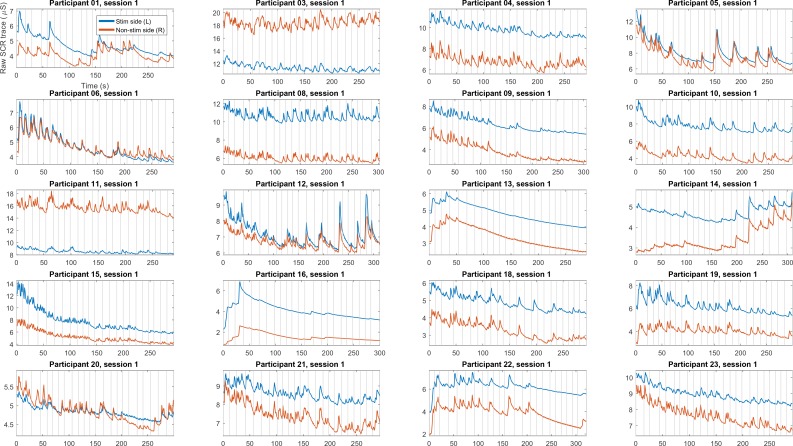
Experiment 2: raw skin conductance traces, where vertical lines are beginning of each trial when cue display starts (n = 20, excluded participants not shown, showing first non-excluded session from all participants).